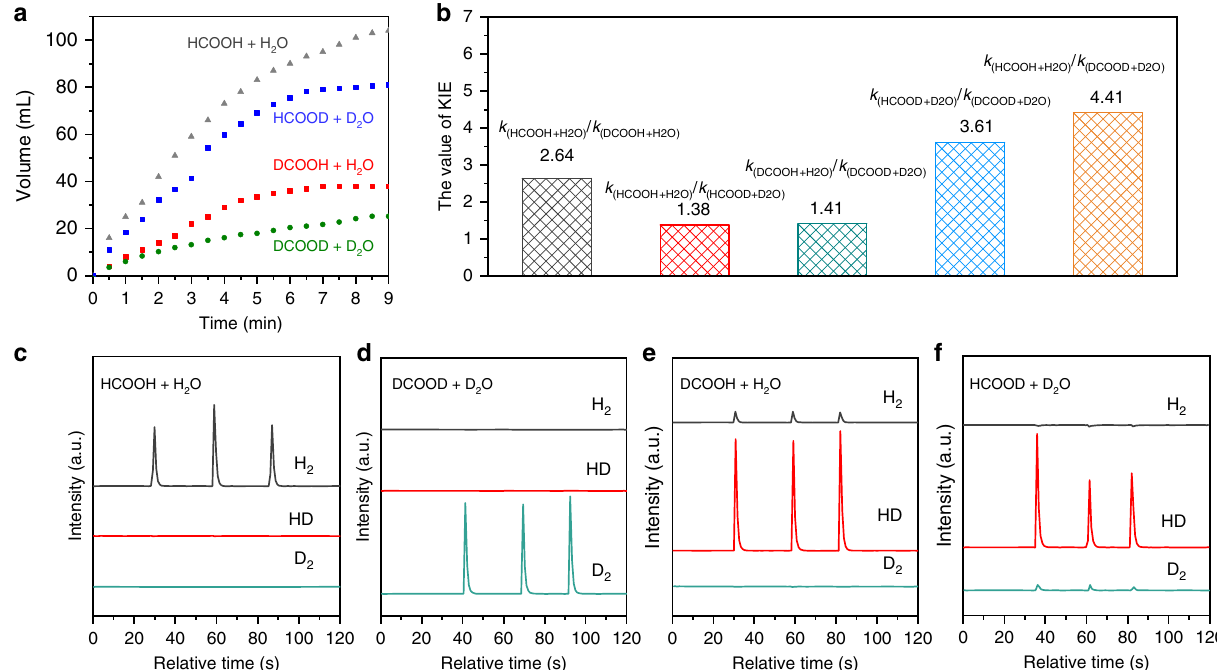
Fig. 4 Isotope-labeled experiments for dehydrogenation of formic acid over Ti 3 C 2 T x -250. a Time course for the volume of gas generated by employing different isotope-labeled reagents. b Kinetic isotope effect data. c – f Detection of the gases of H 2 , HD, and D 2 by mass